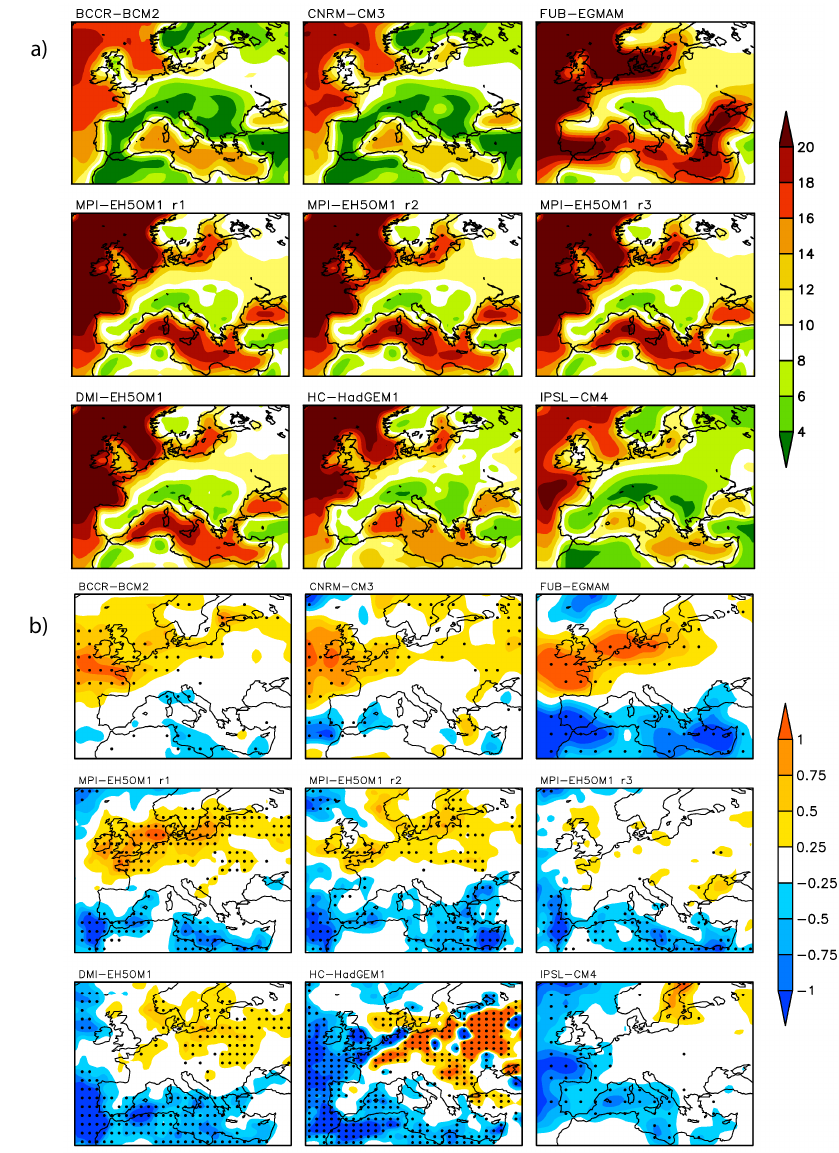
Fig. 2. 98th percentile of daily maximum wind speeds (WIMAX) in the GCM simulations. (a) Absolute values for 20C (generally 1961– 2000, unit: ms − 1 ), (b) changes for A1B (2071–2100) relative to 20C (1961–2000): coloured areas indicate the magnitude of change (unit: ms − 1 ), statistical significance above 0.95 is indicated by black dots (Student’s t-test). and standard deviation that are closest to the insurance